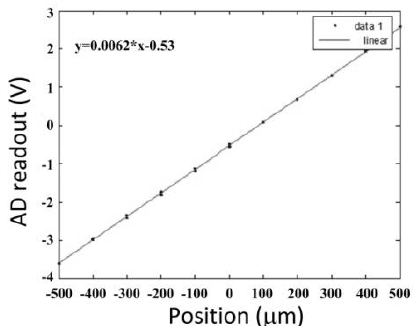
Figure 6. Output voltage vs. Position Sensitive Detector (PSD) position.